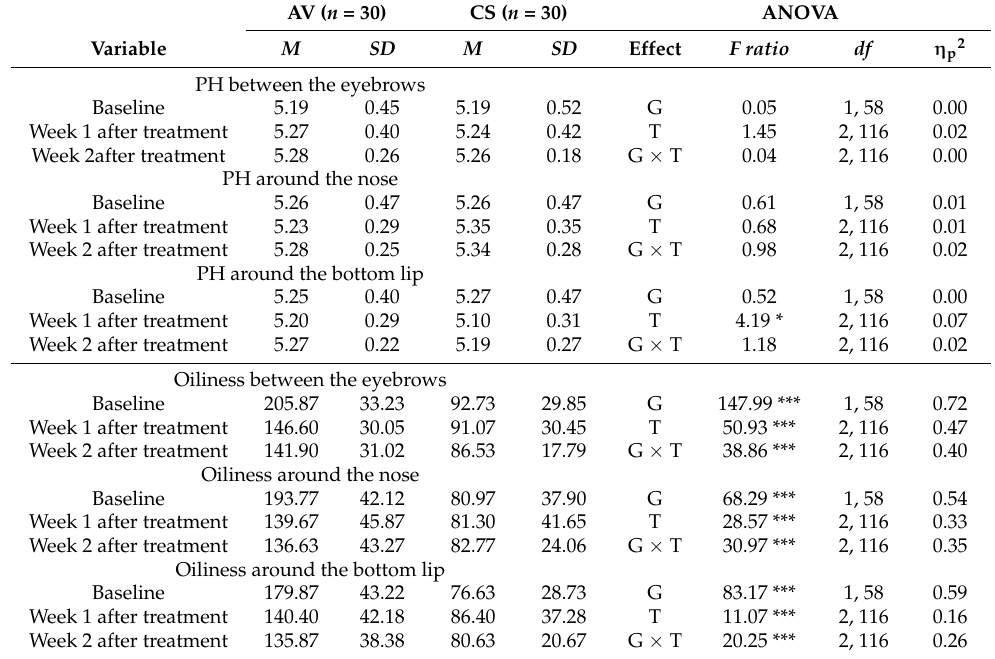
Figure 4. Differences in the HVS between two measurements: at baseline and 14 days after finishing the 4-week treatment of hydrogen purification. Table 2. Means, standard deviations, and two-way ANOVA with repeated measure statistics for study